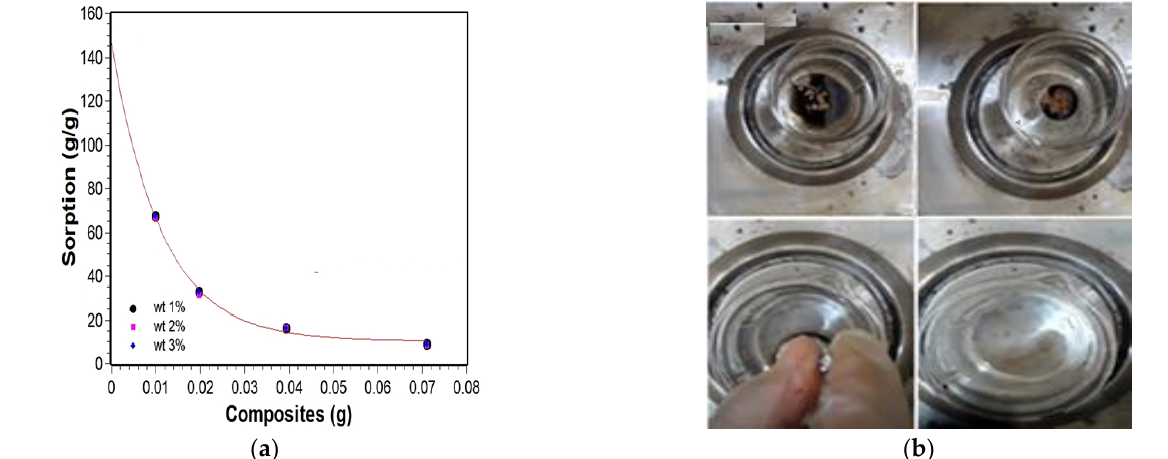
Figure 7. Sorption test geopolymer. ( a ) wt 1%, wt 2%, wt 3%. ( b ) Sorption test. Table 1. Data obtained in exponential